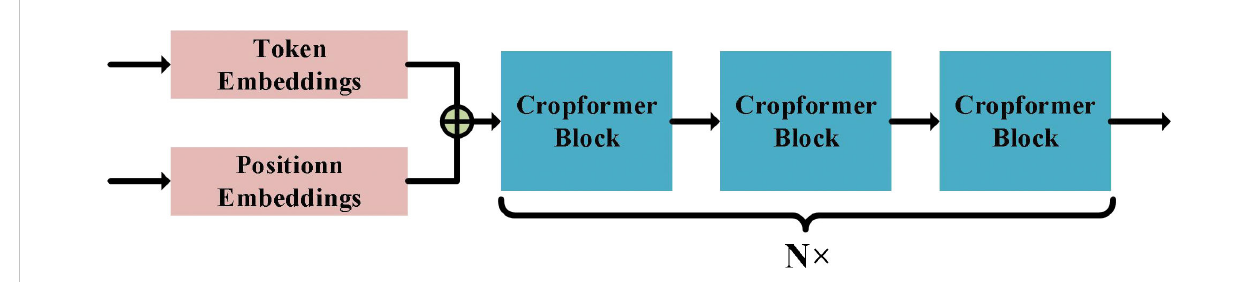
Figure 4A shows that Single MHAL architecture. MHAL takes the joint vector of sequence + doy as input, by performing three linear projections on the input vector. The outputs of the fi rst two Linear Layer are selected for scaled dot product and the fraction of each feature is calculated using Softmax, i.e., Equation. (4). The obtained feature scores are dotted multiplied once more with the output of the third projection, and fi nally the output of MHAL is obtained. MHAL is to calculate the feature scores between different positions of sequences, it learns the dependencies between sequences and obtains the global sequence information. The weight of the important sequence information in this part is scaled up, making more emphasis on this part in the CM part.